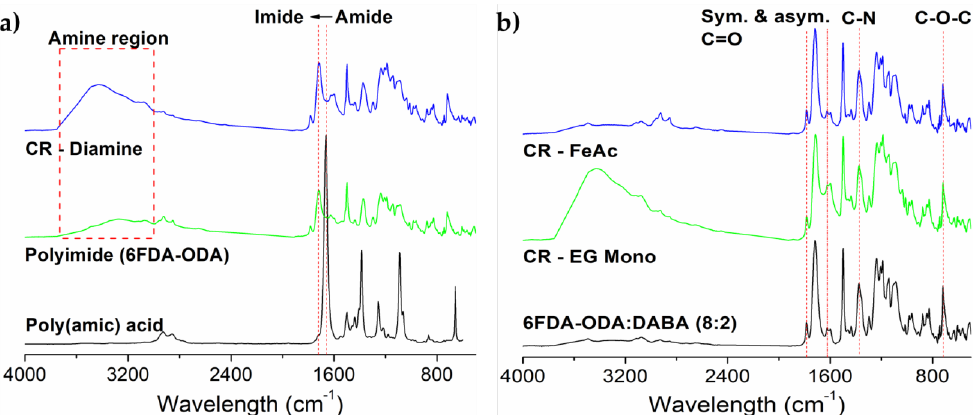
Figure 5. FTIR spectra of ( a ) neat 6FDA-ODA membrane (with the spectra of its poly(amic) acid, prior to the imidization and its crosslinked m -xylylene diamine membrane), and ( b ) neat 6FDA-ODA:DABA (8:2) membrane (with the spectra of its ethylene glycol (EG) and iron (III) acetylacetonate crosslinked membranes).